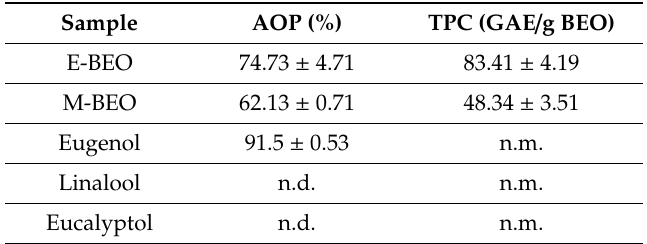
Table 2. Antioxidant power (AOP) and total phenolic content